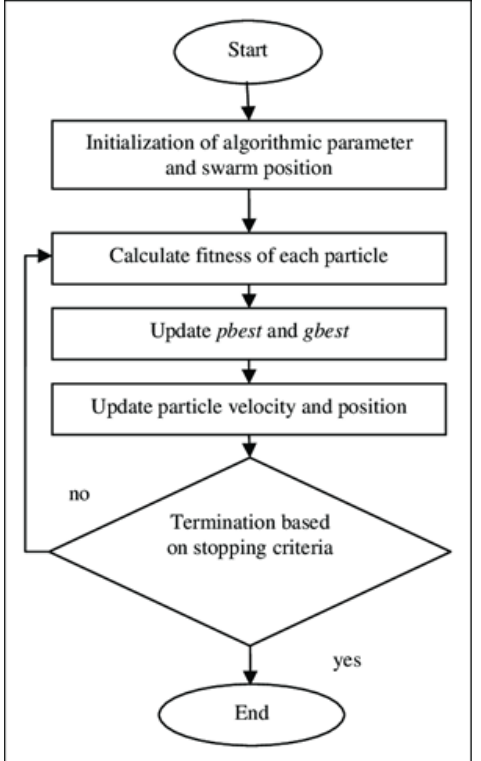
Figure 1: Main steps of the PSO